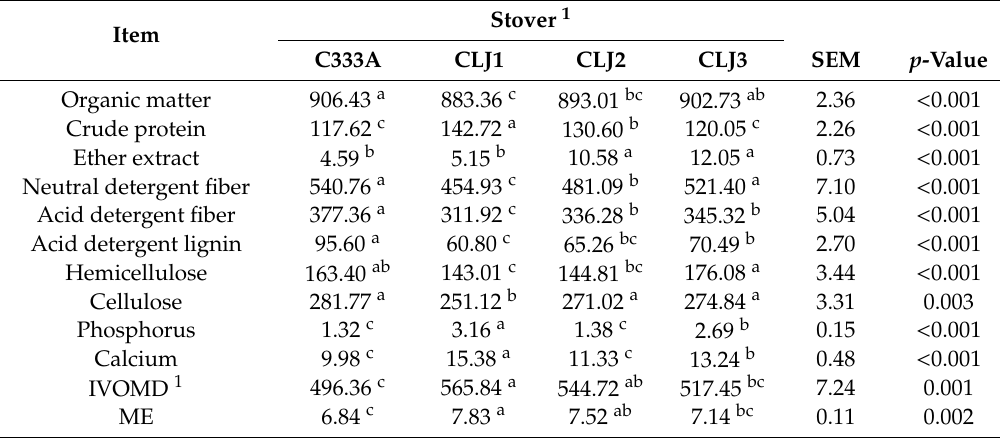
Table 2. Chemical composition (g / kg DM) and nutritive value of the stovers from four varieties of common vetch.